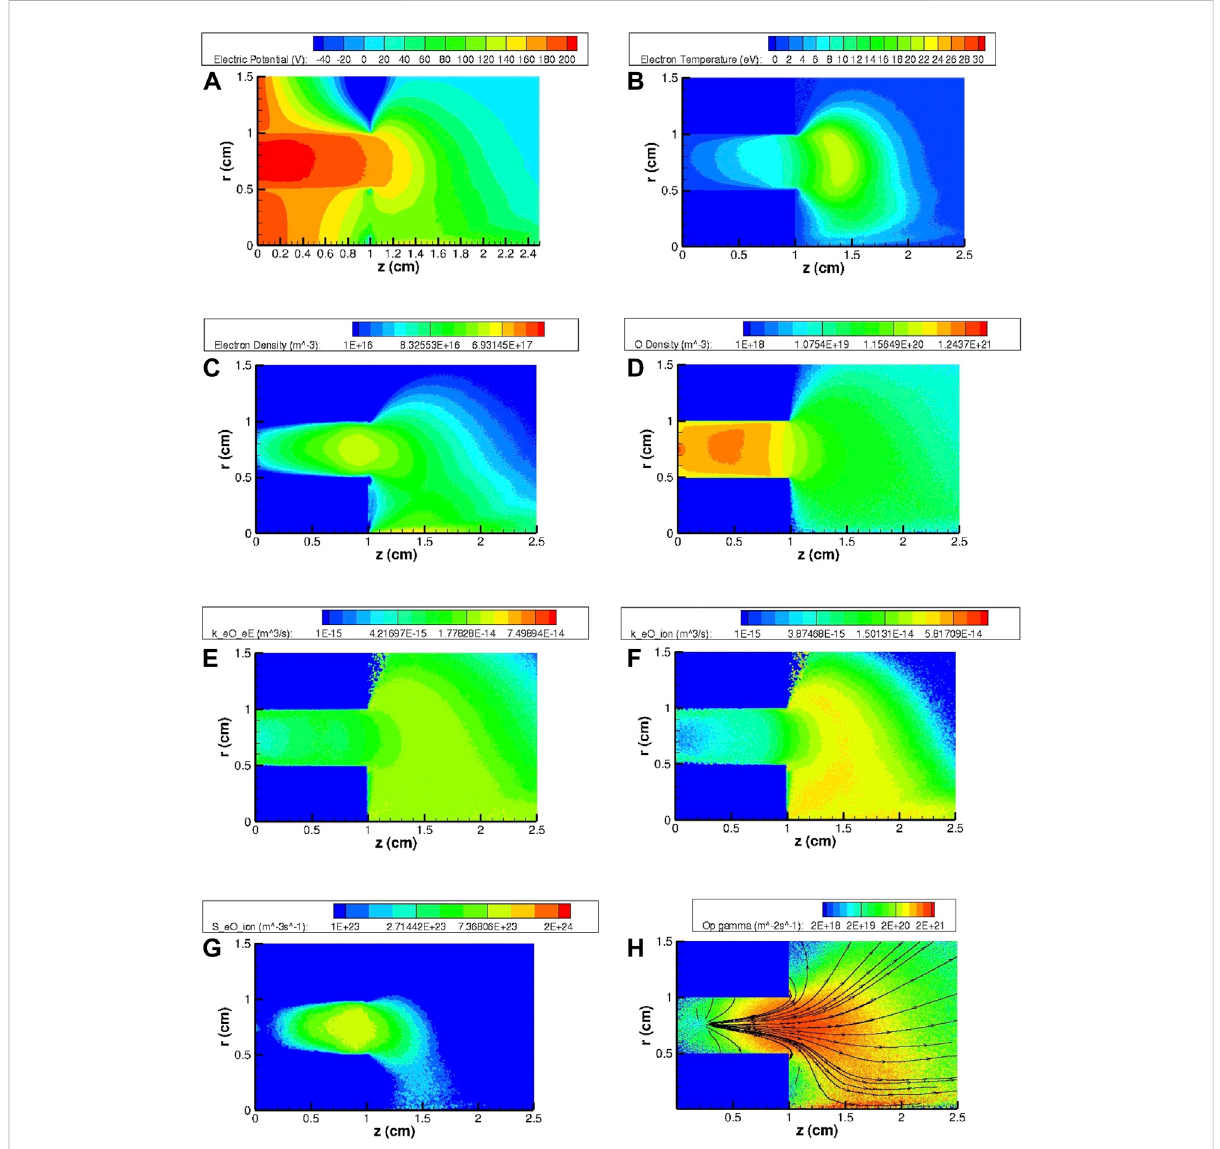
FIGURE 10 Two-dimensional maps of the most relevant HT plasma and gas parameters for the SPT20 nominal case using N 2 and O (case D) as the propellant: (A) electricpotential ϕ (V), (B) electrontemperature T e (eV), (C) electrondensity n e (m − 3 ), (D) atomicdensity n O (m − 3 ), (E) and (F) electronic excitation and ionization rate coef fi cients, k eE , O and k ion , O (m 3 s − 1 ) (Eq. 18), (G) ionization source term S ion , O (m − 3 s − 1 ) and (H) ion fl ux Γ O + (m − 2 s − 1 ) obtainedbyaveragingoverthelast1500PICcyclesforplasmaquantities (A – C,E – H) andoverthelast1500TPMCiterationsforgasquantity (D)